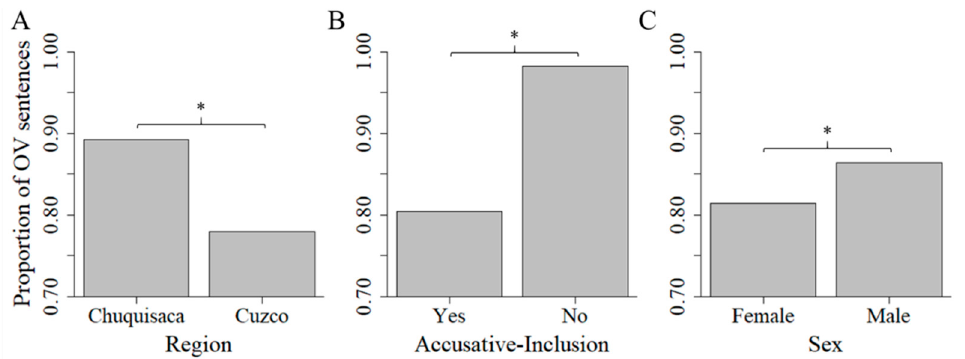
Figure 2. Proportion of OV sentences by ( A ) Region, ( B ) Accusative-Inclusion, and ( C ) Sex. Asterisks indicate that the difference between levels is significant ( p < 0.05).